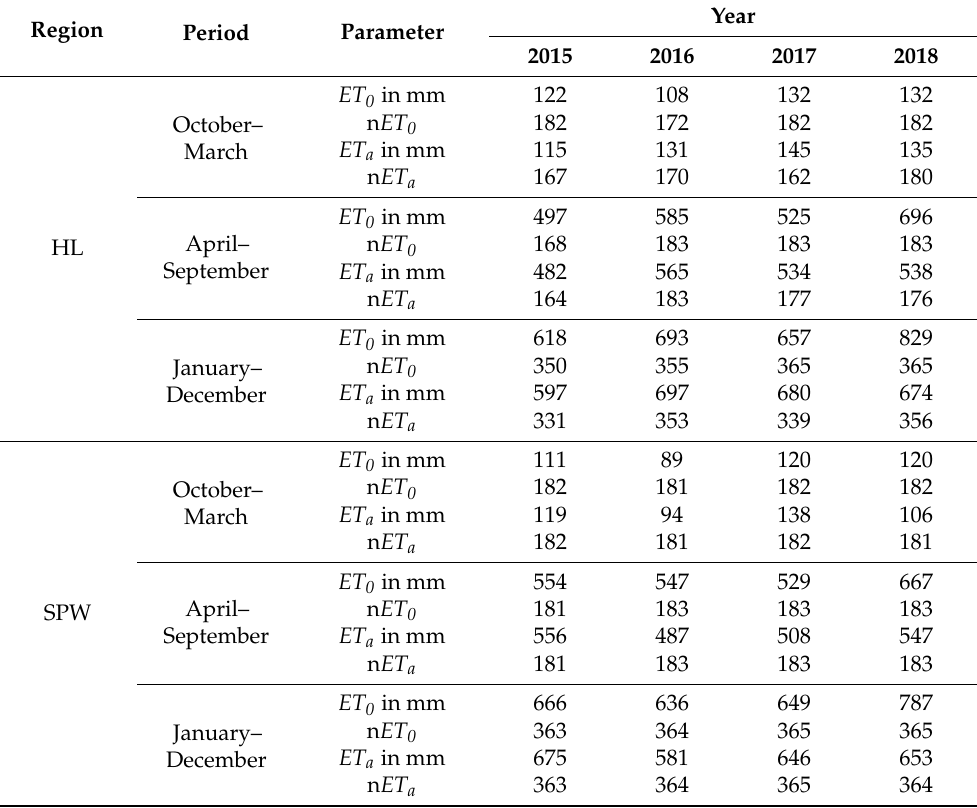
Table 3. Annual and half-year sums of FAO grass reference evapotranspiration ( ET 0 ) and actual evapotranspiration ( ET a ), along with the number of days with measured values (n ET 0 , n ET a ) in the study years 2015 to 2018 in Havelländisches Luch (HL) and Spreewald